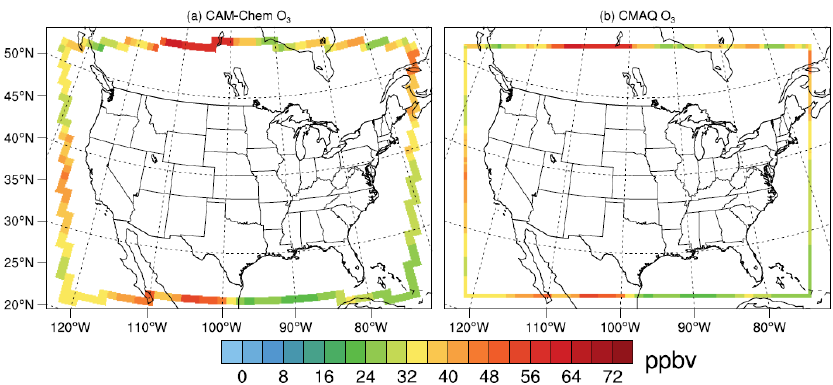
Fig. 2. Boundary comparisons between CAM-Chem and CMAQ for O 3 concentrations on 1 July 2001, as an example. Table 2. Anthropogenic and biogenic emissions compared to base year (2005) emissions in the US. Present climate